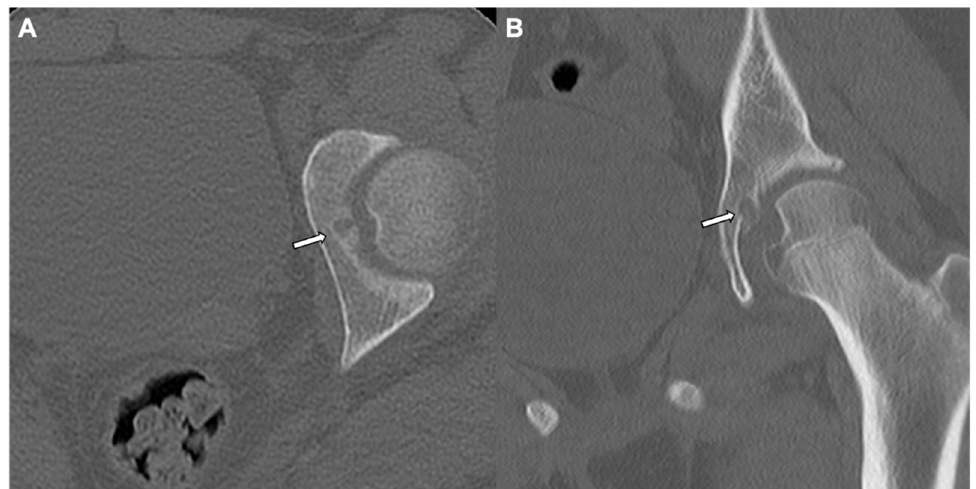
Figure 5. Subperiosteal osteoid Osteoma: A left hip CT bone window (axial view ( A ) and coronal view ( B )) in a 14-year-old male shows well defined lucency with focal cortical truncation involving the left superomedial acetabular surface without surrounding sclerosis (white arrows) and suggests an intraarticular subperiosteal osteoid osteoma.